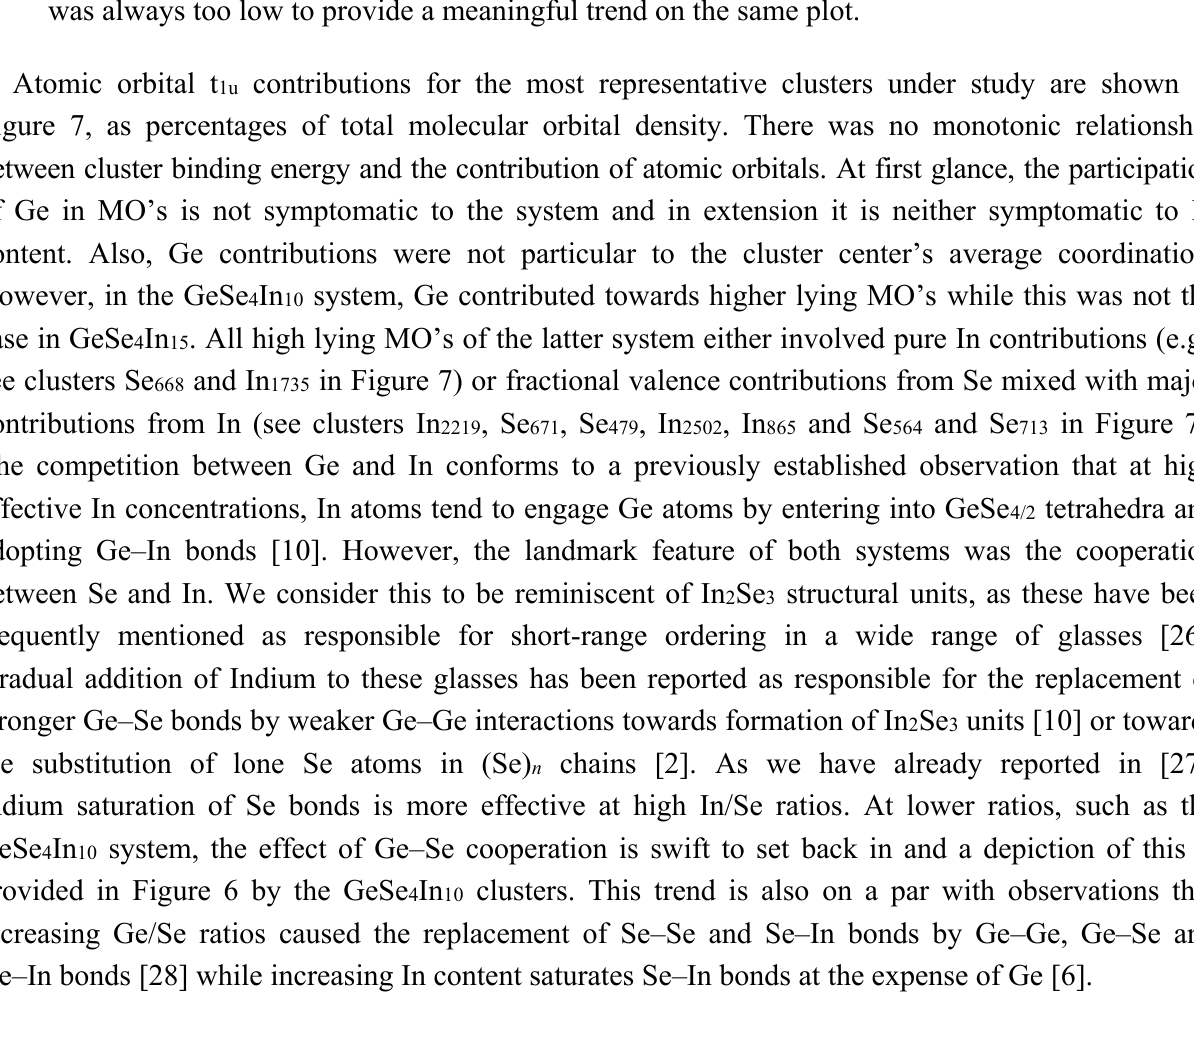
Figure 6. Cluster binding energy, normalized by the number of electrons in each cluster, in respect to the center’s partial coordination numbers by the Se and In species. Ge content was always too low to provide a meaningful trend on the same